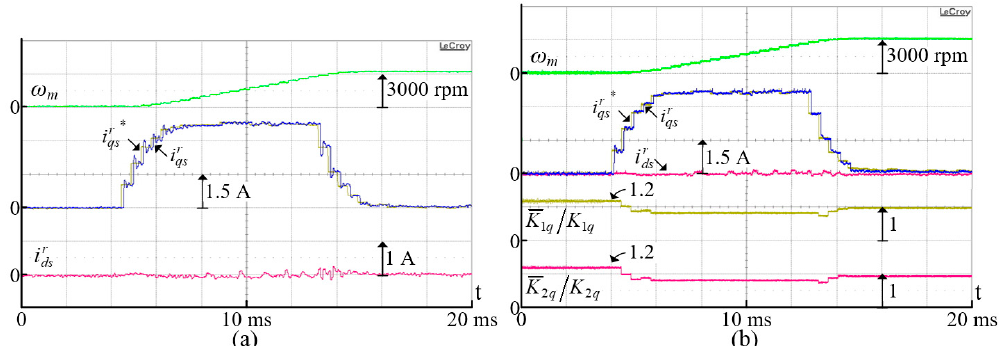
Figure 25. The amplified current response in the acceleration region of Figure 23 with ˆ L qs = 1.2 L qs when the online current loop tuning is ( a ) de-activated and ( b ) activated.